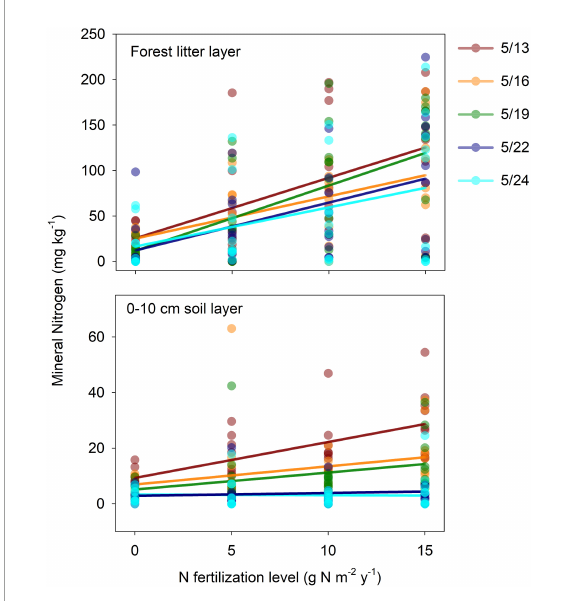
FIGURE3 The relationship between mineral nitrogen concentration (NO 3 − -N+ NH 4 + -N) and N fertilization levels in both forest litter layer (left) and 0–10 cm soil layer. Fertilization was applied three times a year since 2009, and the last N application was on 5/11/2011. Mineral N concentration assay was performed on 5/13, 5/16, 5/19, 5/22, and 5/24/2011. Significant (or marginally significant) positive correlations were found between mineral N concentration and N fertilization levels in the litter layer ( r 2 = 0.32, P < 0.001 for 5/13, r 2 = 0.29, P < 0.001 for 5/16, r 2 = 0.38, P < 0.001 for 5/19, r 2 = 0.26, P = 0.001 for 5/22, and r 2 = 0.17, P = 0.013 for 5/24), as well as in the 0–10 cm soil layer except those on 5/22 and 5/24 ( r 2 = 0.41, P < 0.001 for 5/13, r 2 = 0.10, P = 0.06 for 5/16, r 2 = 0.14, P = 0.025 for 5/19,